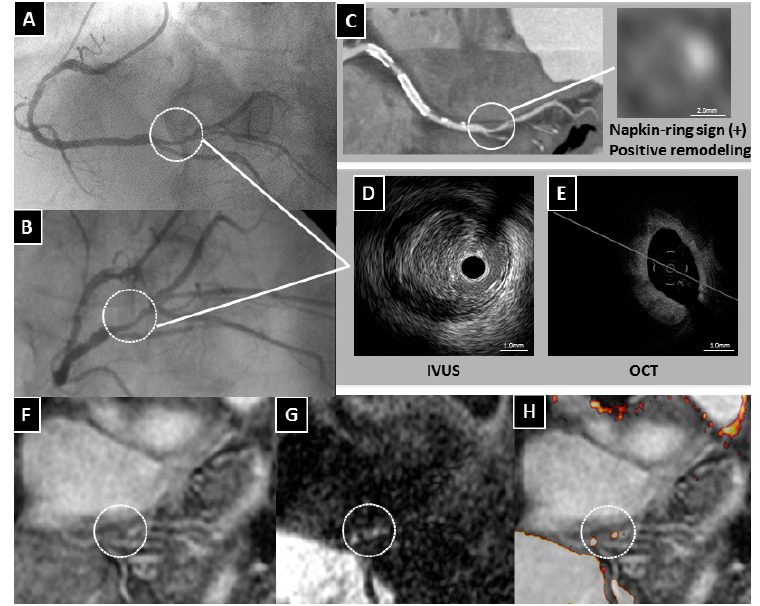
Figure 2. A representative case of an intrawall HIS lesion on T1WI compared with plaque morphology on CT, IVUS and OCT. ( A , B ) Coronary angiography revealing severe coronary stenosis (circle) in the distal right coronary artery (RCA); ( C ) Coronary CT angiography showing the napkin-ring sign and positive arterial remodeling; ( D ) The IVUS image showing a low attenuation plaque; ( E ) The OCT examination showing a signal-poor region with irregular high- or low-backscattering borders without thrombus; ( F ) Whole-heart coronary MR angiography showing significant stenosis in the distal RCA (circle); ( G ) Coronary T1WI demonstrating intrawall HIS (circle); ( H ) Fused image showing intrawall HIS (circle) in the area corresponding to the severe stenosis.